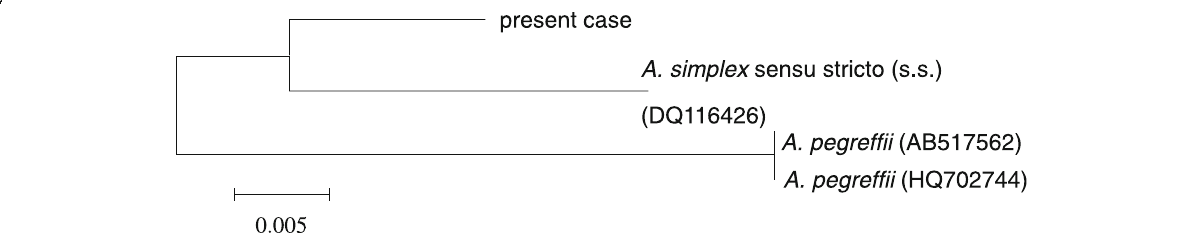
Fig. 2 Phylogenetic analysis of Anisakis species based on COX2 sequences (532 bp). Nucleotide sequences were aligned and phylogenetic